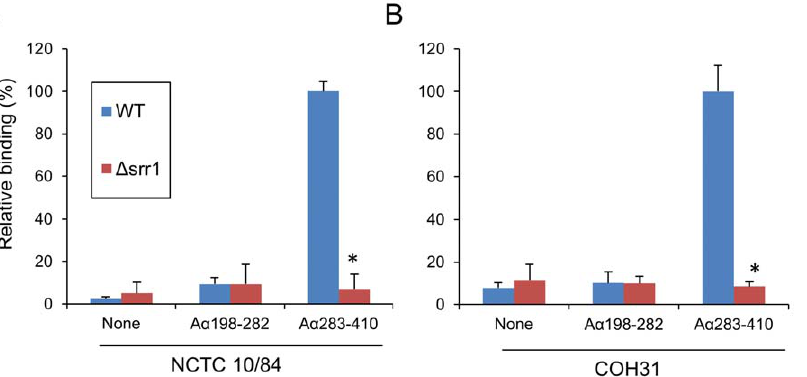
Figure 7. GBS binding to fibrinogen A a variants. GBS strains NCTC 10/84 (A) and COH31 (B) were compared with their D srr1 variants ( D srr1 ) for binding to MalE:A a 198–282 or MalE:A a 283–410 . Values are mean 6 S.D. percent of WT GBS binding to immobilized MalE:A a 283–410 . *=P , 0.01.